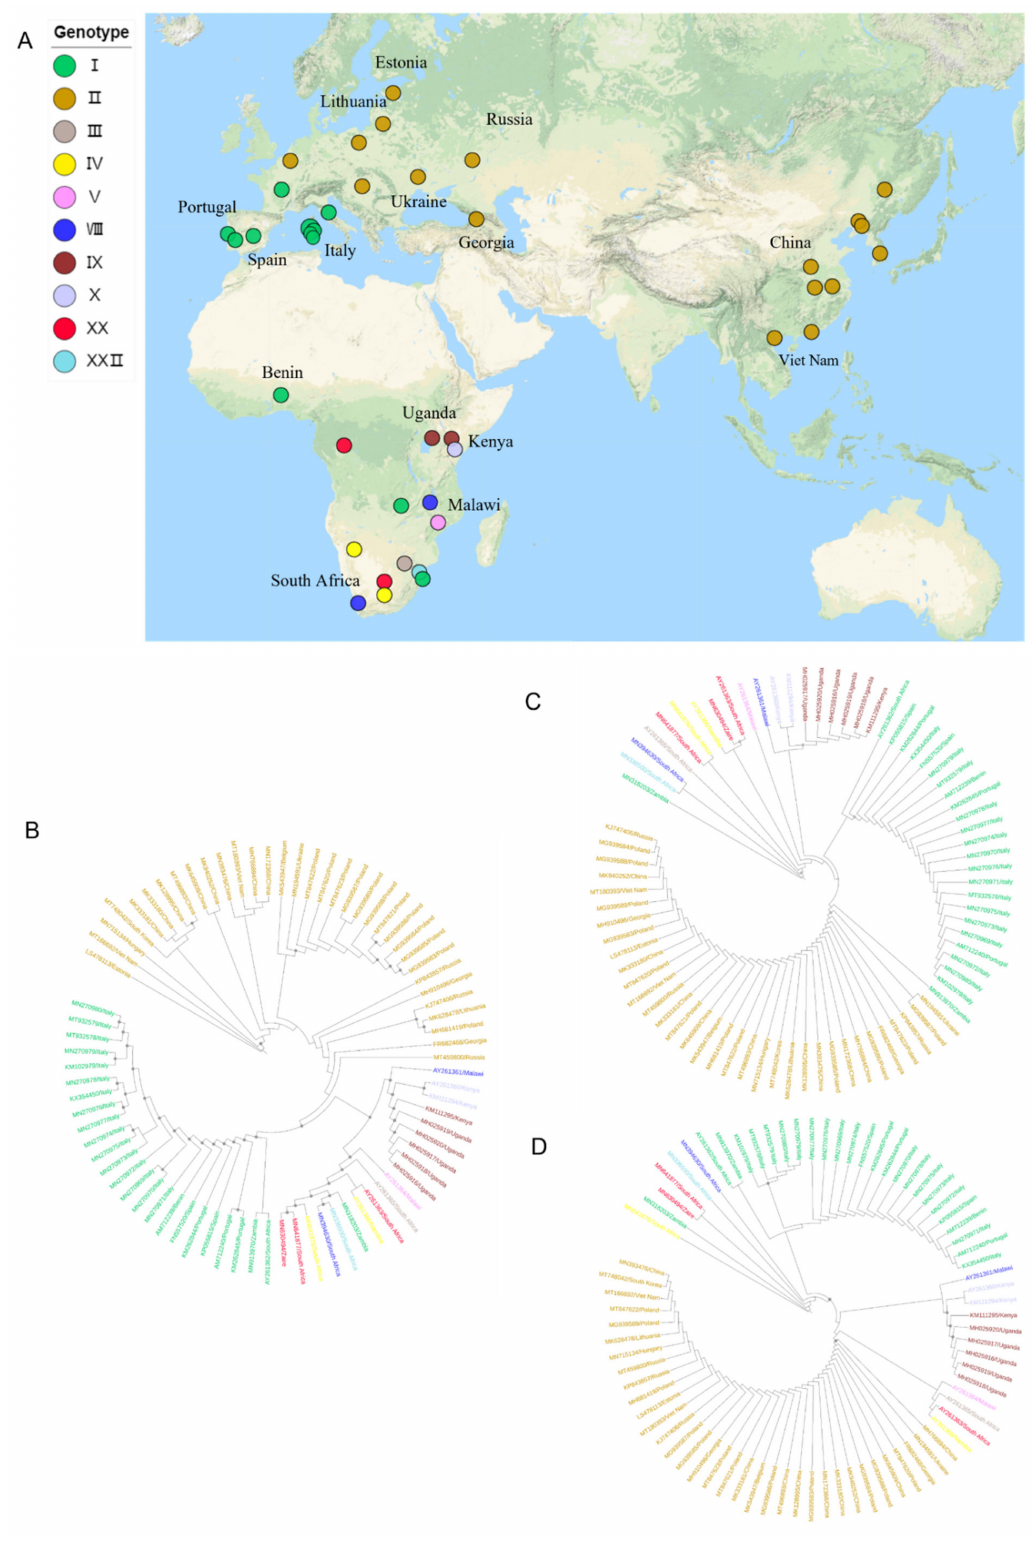
Figure 1. Phylogenetic relationships of the African swine fever virus isolates: ( A ) geographical distribution of ASFV in this study; ( B ) maximum-likelihood tree of 77 ASFV isolates based on complete genome sequences; ( C ) maximum-likelihood tree of 77 ASFV isolates based on E183L sequences; ( D ) maximum-likelihood tree of 77 ASFV isolates based on B646L. Different colors represent various p72